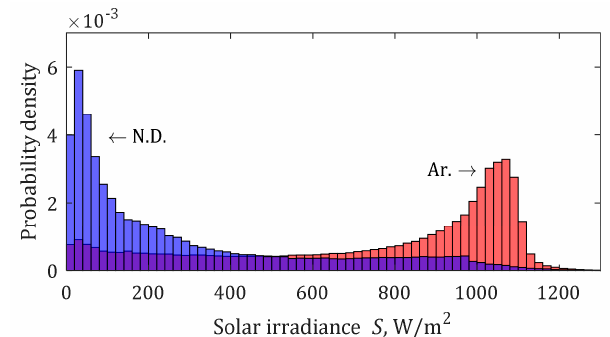
Figure 10. Density distribution of the solar irradiances.